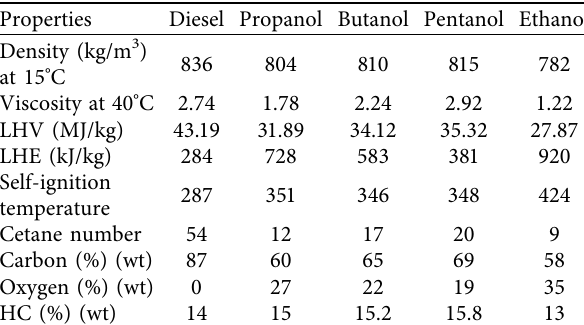
Table 2: Engine set up.